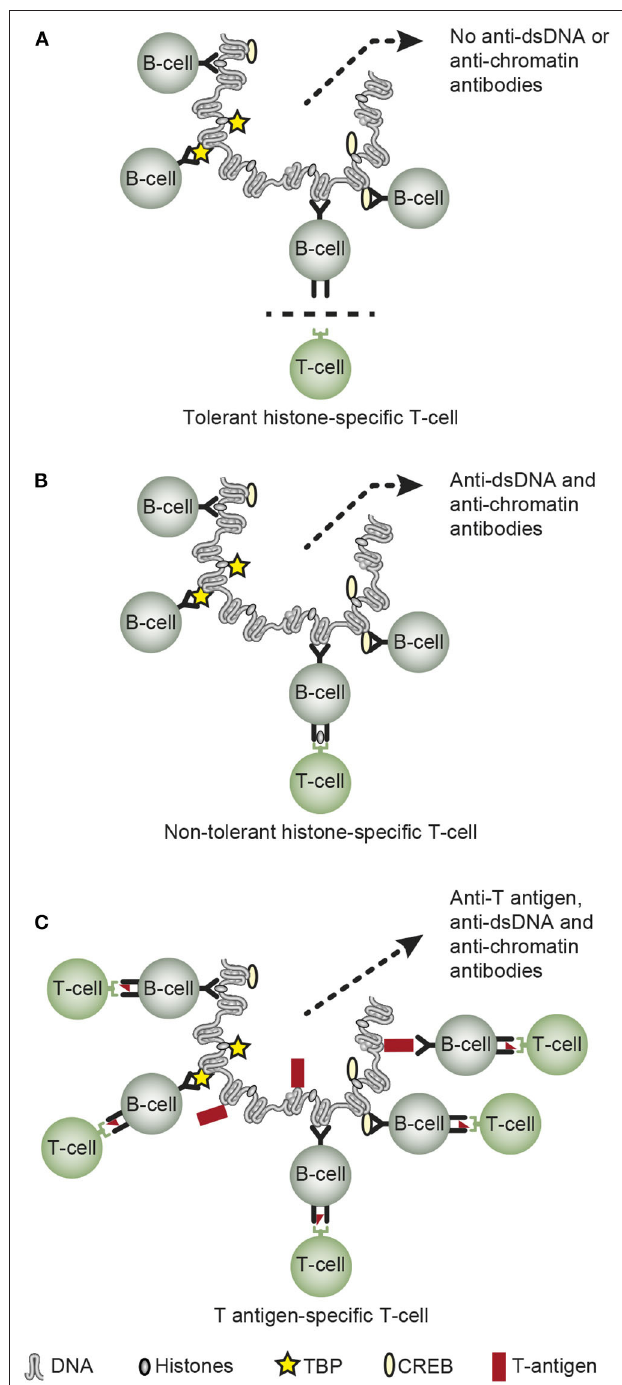
FIGURE 3 | Principal basic problems attempting to describe how or why chromatin/dsDNA execute their immunogenic potential in vivo . Concerning the origin of anti-dsDNA antibodies, they are not induced on a normal immune background by exposure of pure autologous chromatin [ A , (7, 111, 112, 129, 134, 136)], although autologous chromatin may gain immunogenic power in situations where helper T cell tolerance is truly terminated as demonstrated in SLE [ B , (141, 144–146)]. Infections may provide chromatin-binding non-self-proteins that allow cognate interaction of